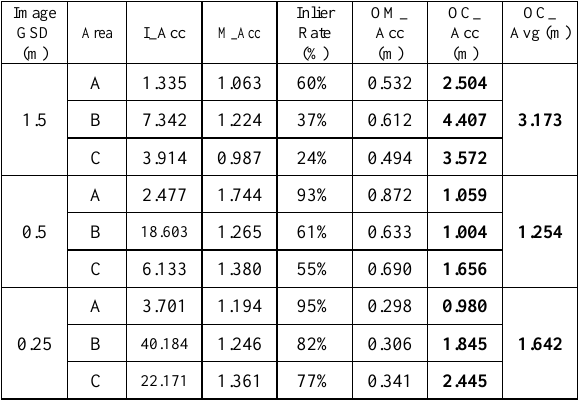
Table 5. Measurement of GCP Chip matching performance of Kompsat-3A image by GSD.